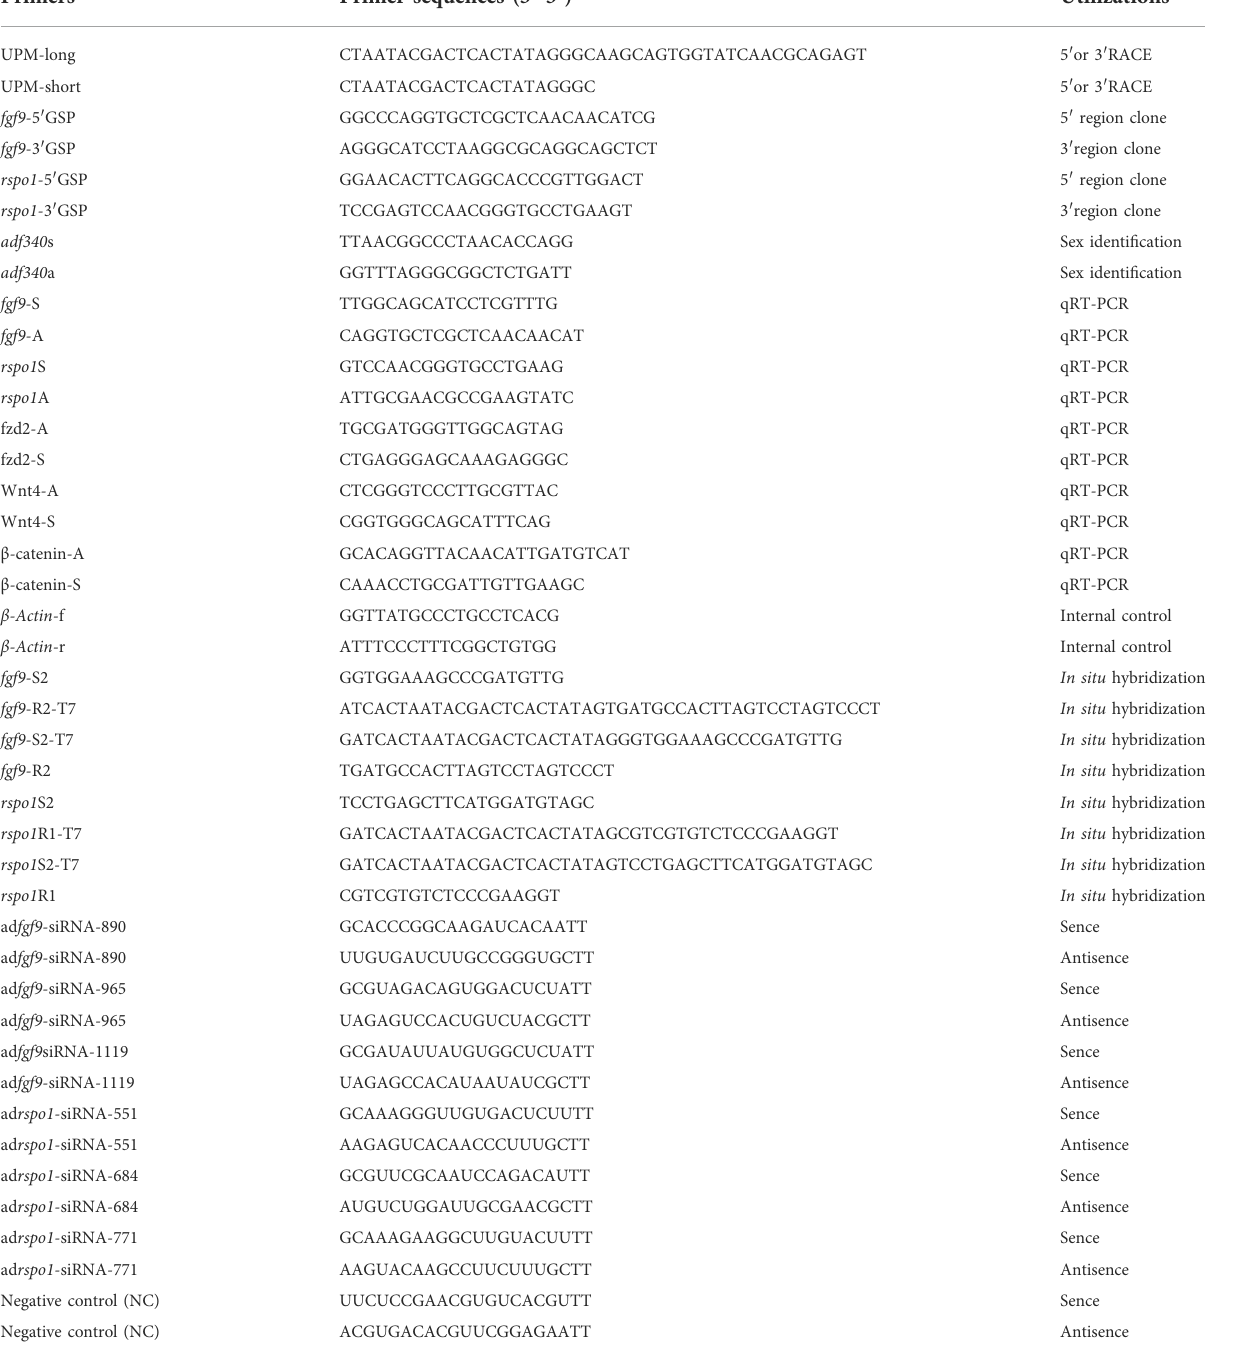
TABLE 1 Primers and sequences used in this